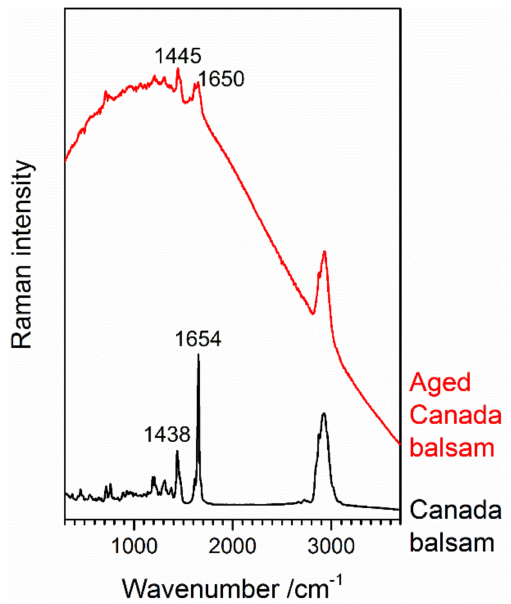
Figure 12. Raman spectra of Canada balsam before and after accelerated ageing at T = 80 ◦ C for 10